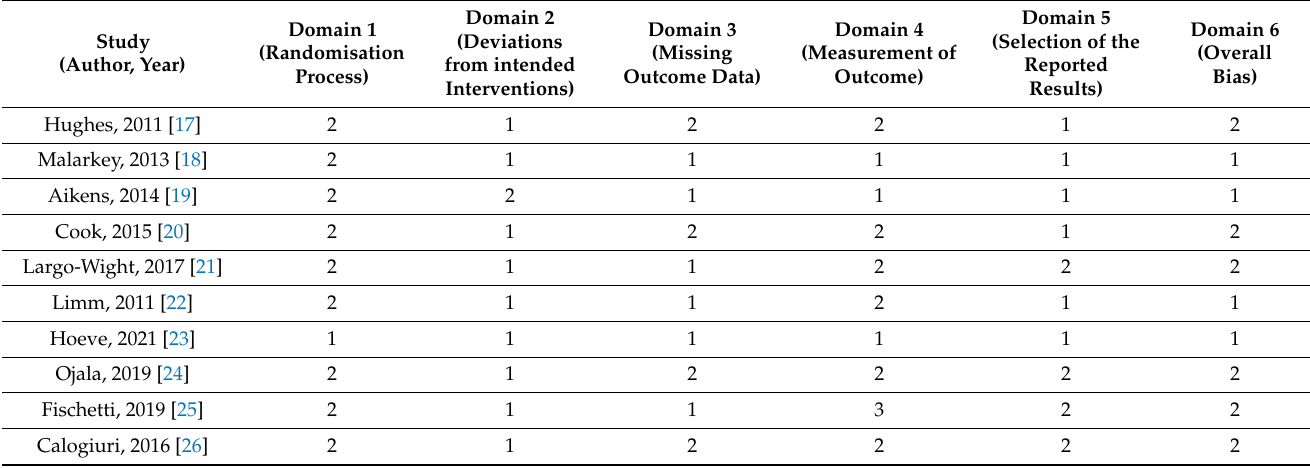
Key for Table 5: 1 = Low Risk of Bias. 2 = Some Concerns. 3 = High Risk of